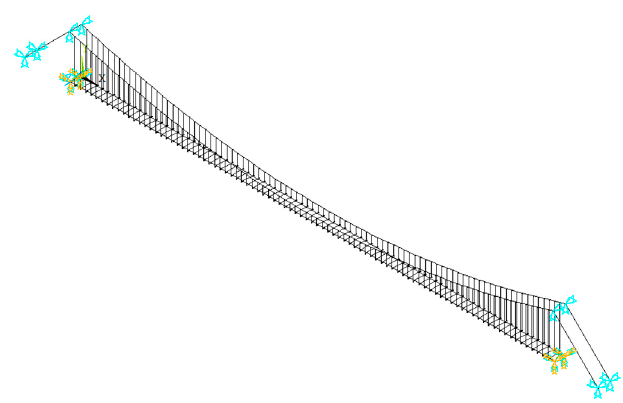
Figure 10. General view of the FE model of the footbridge.